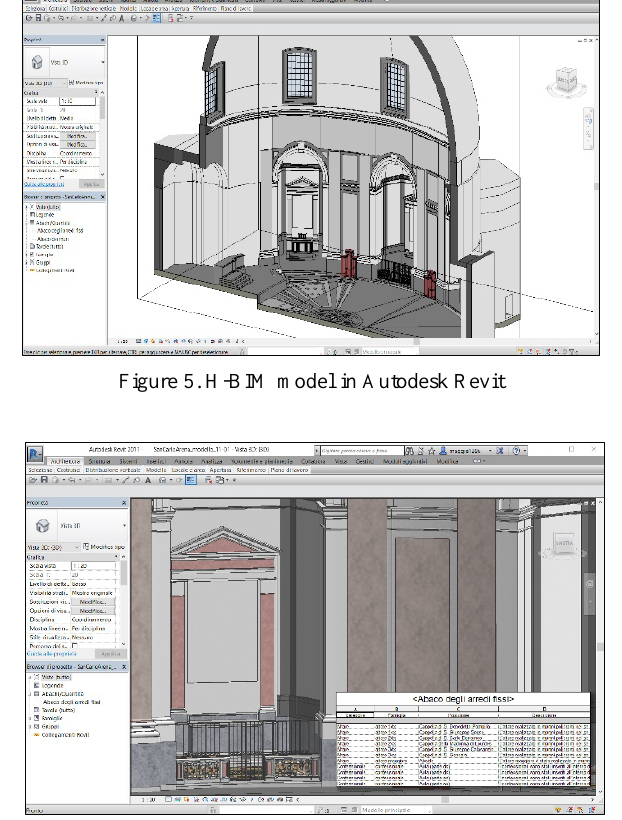
Figure 6. H-BIM model in Autodesk Revit with database of internal decorative apparatus.